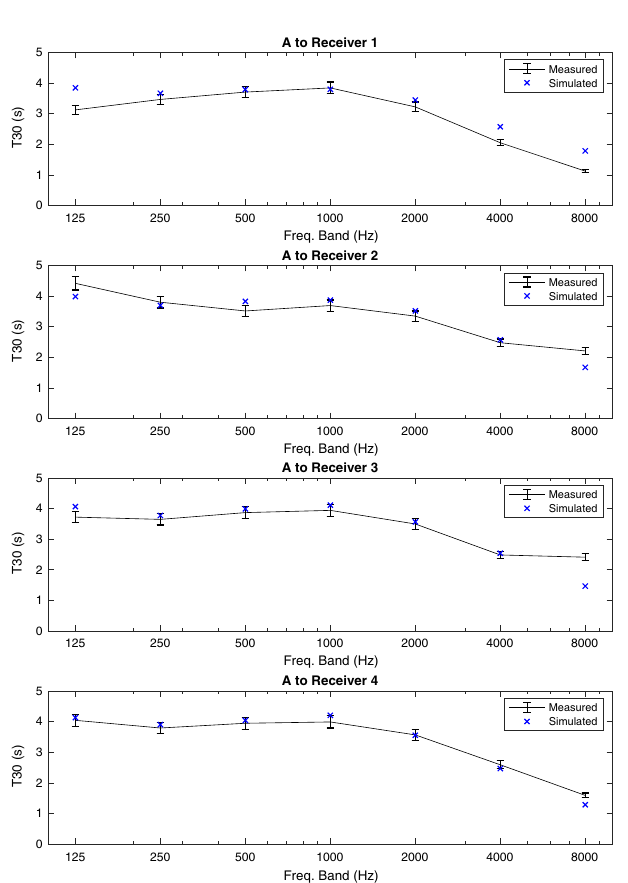
Figure 5. T30 simulations versus measurements from source position A (Error bars = ±1 JND).